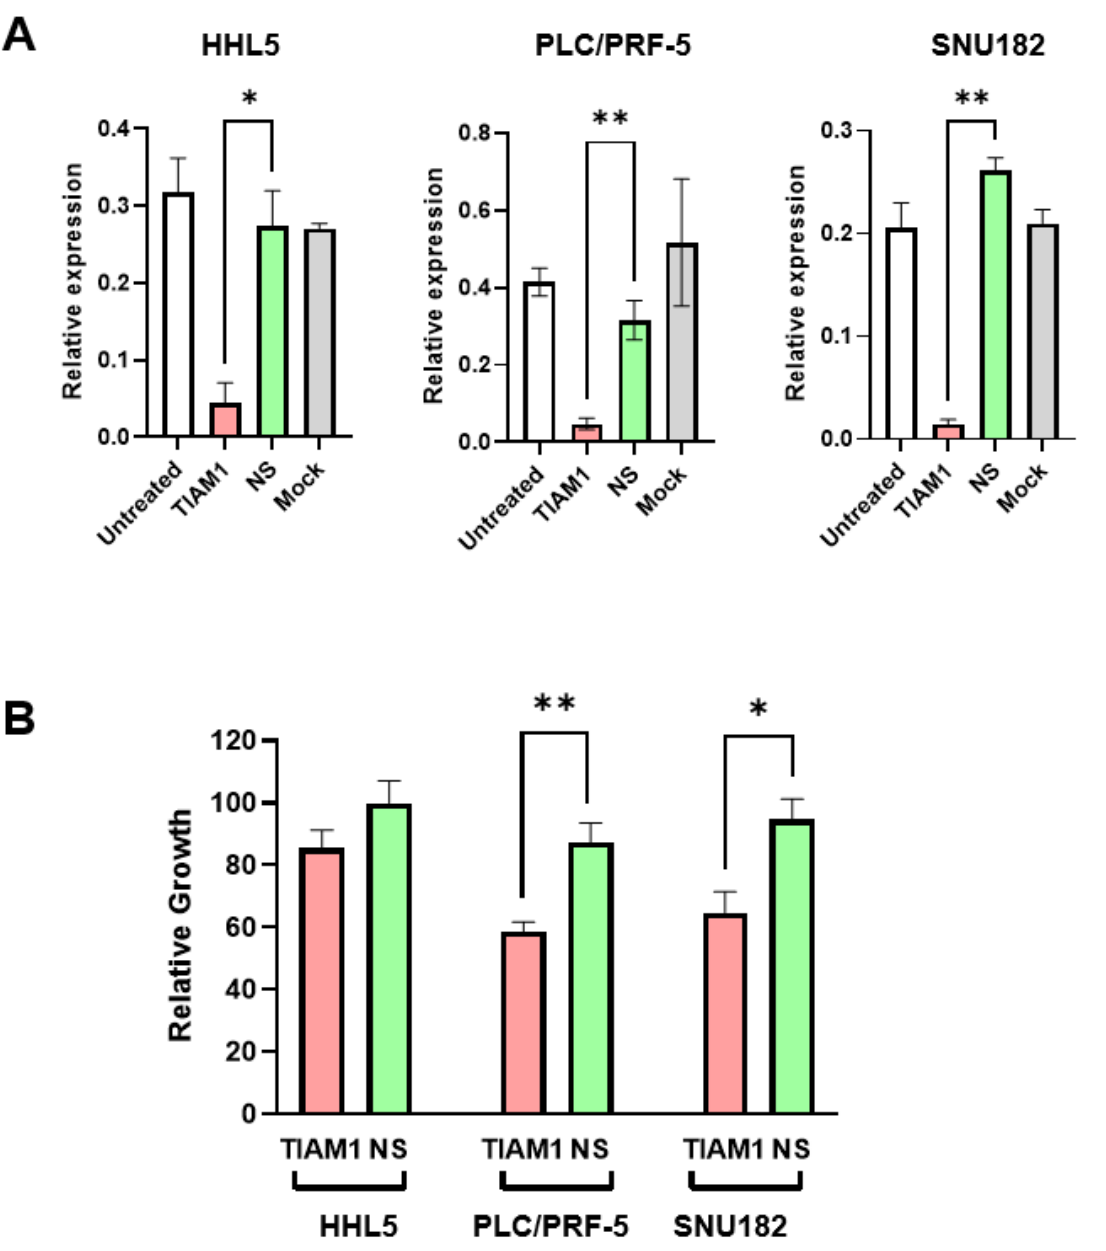
Figure 5. TIAM1 knockdown results in reduced growth in HCC subgroup-2 cell lines. ( A ) RT-qPCR results of cells 48 h post-transfection with indicated siRNAs (TIAM1 or NS (non-silencing)) or controls (Unt = untreated, Mock = only transfection reagent treatment) in HHL5, PLC/PRF-5, and SNU182. Data were calculated as 2 − ∆ Ct relative to the housekeeping control HPRT. Values shown are mean ± SE. * p < 0.05, ** p < 0.005, Student’s T-test assuming equal variance, n = 2–4 ( B ) Cell growth in HCC cell lines following treatment with TIAM1-specific or control non-silencing (NS) siRNA as determined by MTT assay. Graph represents relative growth in indicated conditions compared to growth of respective cell line under mock treated conditions, 6 days after the transfection. * p < 0.05, ** p < 0.005, Student’s T-test assuming equal variance, n = 5.